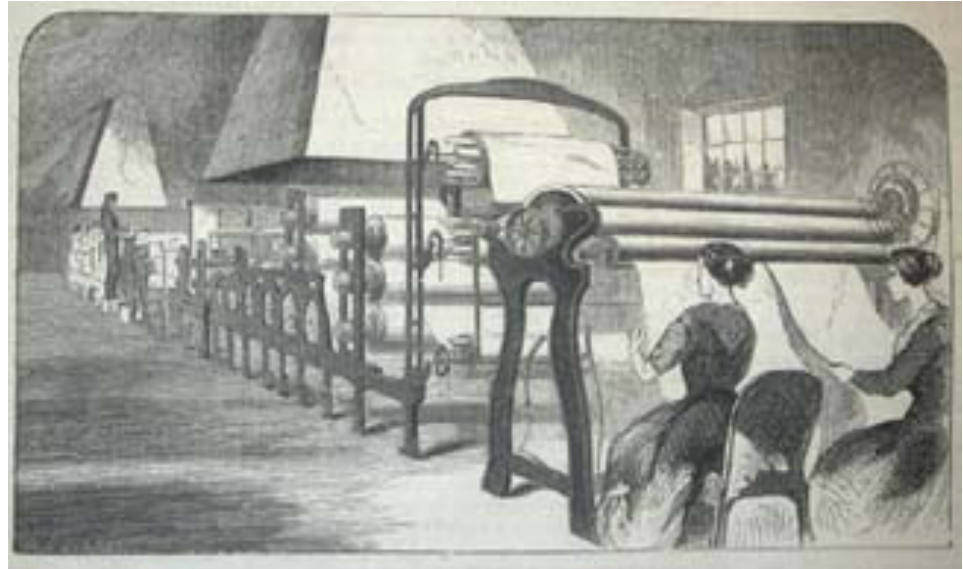
Figure 11. Women at Foudrinier machine. Ballou’s Pictorial , June 0, 1855. American Antiquarian Society. Available online: https://www.americanantiquarian.org/Exhibitions/Womanswork/factory. htm (accessed on 29 August